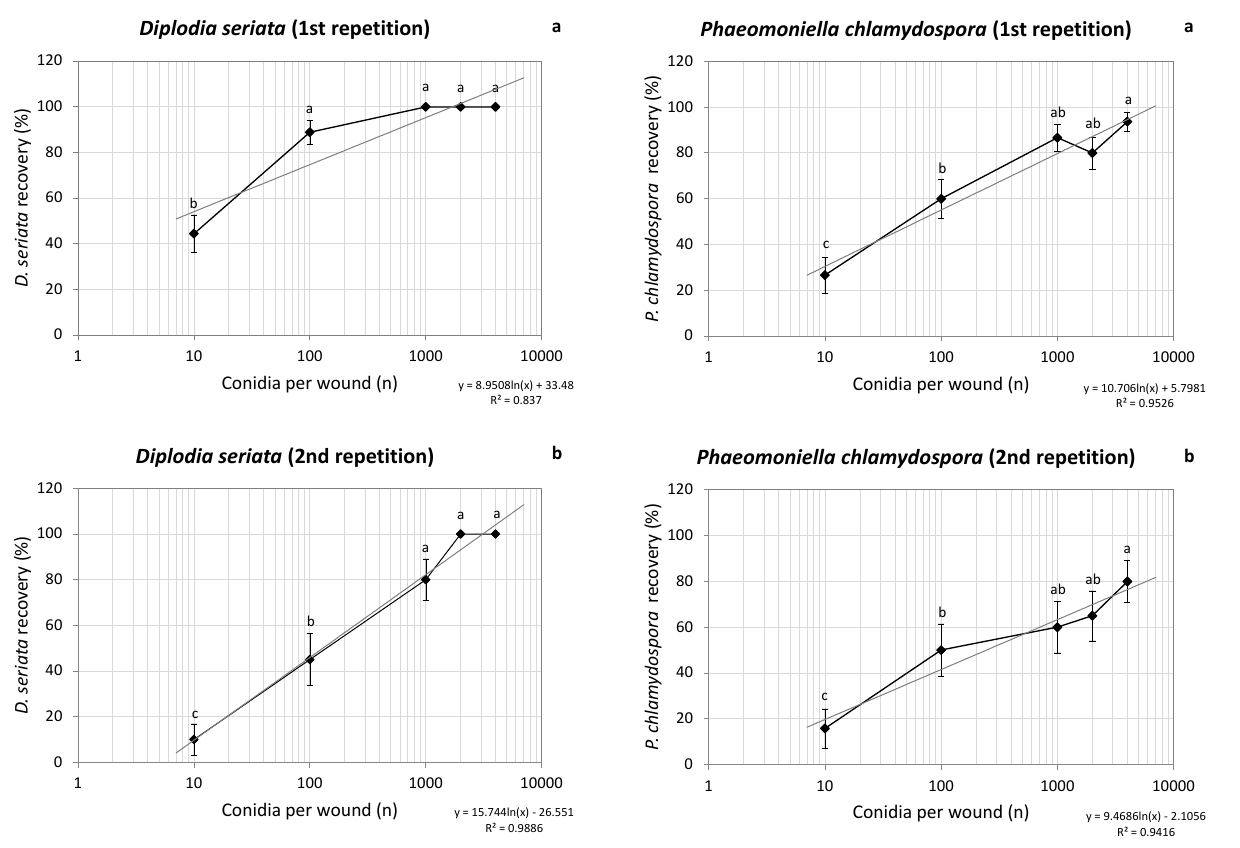
Figure 1. Mean percentage recovery from the two potted vine experiments (cv. Tempranillo) inoculated with Diplo- dia seriata . Twenty replications (canes) per pathogen were used for each experiment and two canes per vine allocated with each inoculum dosage of 10, 100, 1000, 2000 or 4000 conidia/wound. Significant differences among means ( P <0.05) are indicated by different letters. Bars correspond to the standard error of the mean.